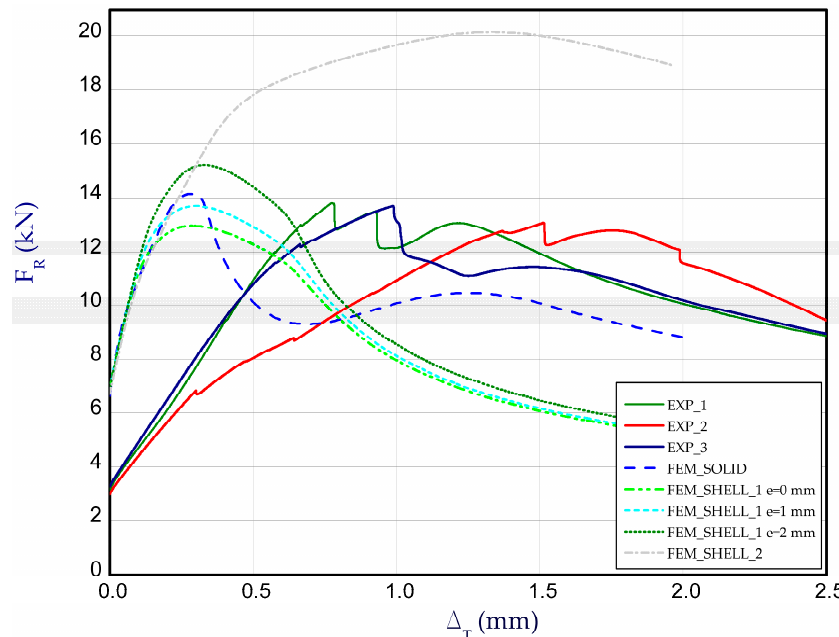
Figure 12. The compression curves of column at 50 °C.